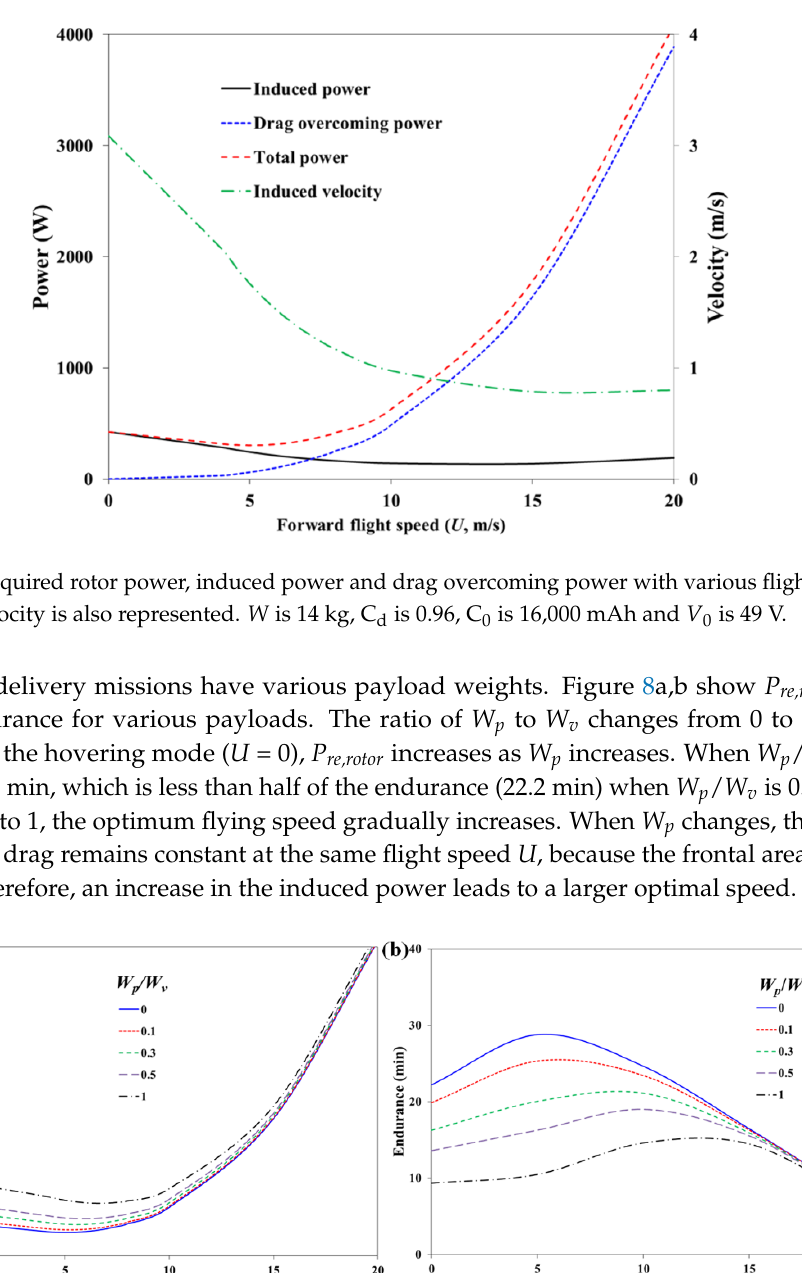
coefficient is 0.96, C 0 is 16,000 mAh and V 0 is 49 V.